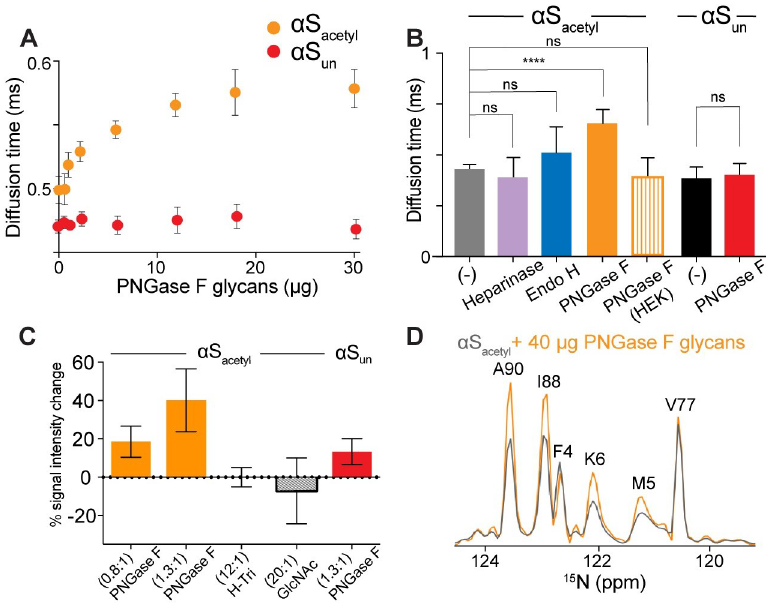
Fig 6. Binding of α S acetyl to isolated cell-surface N-linked glycans. (A) Diffusion time of α S acetyl -AL488 and α S un - AL488 (80 nM) as a function of PNGase F–derived glycan concentration measured by FCS. (B) Comparison of α S acetyl - AL488 and α S un -AL488 binding to carbohydrates (30 μ g) cleaved by the indicated endoglycosidases as measured by FCS. (C) Percent increase in peak intensity for selected residues ( n = 9: T22, K32, T44, H50, T59, T64, G86, G93, and N103) strongly enhanced by glycan binding relative to selected residues ( n = 9: A17, A27, L38, V40, V71, V95, I112, E130, and Y136) weakly affected by glycan binding. Measurements were performed for α S acetyl in the presence of PNGase F–cleaved glycans, H-Tri, and GlcNAc and for α S un with PNGase F–cleaved glycans. The ratio of sugar to protein used is indicated. (D) Cross-sections from 15 N- 1 H HSQC spectra along the nitrogen dimension at 8.15 ppm for α S acetyl in the absence (gray) and in the presence of PNGase F–derived glycans (orange). For (A–C), data are presented as mean ± SD, n = 3. ��� P < 0.0001 by Student t test). The underlying data for this figure can be found in S1 Data. α S, α -Synuclein; α S acetyl , N-terminally acetylated α S; α S un , unmodified α S; AL488, Alexa Fluor 488; FCS, fluorescence correlation spectroscopy; GlcNAc, N-acetylglycosamine; H-Tri, H-Trisaccharide; ns, not significant; HSQC, heteronuclear single quantum coherence; PNGase F, peptide-N-glycosidase F.